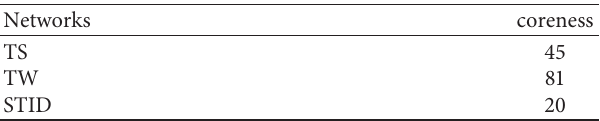
Table 3: The coreness of earthquake networks constructed by TS, TW, and STID